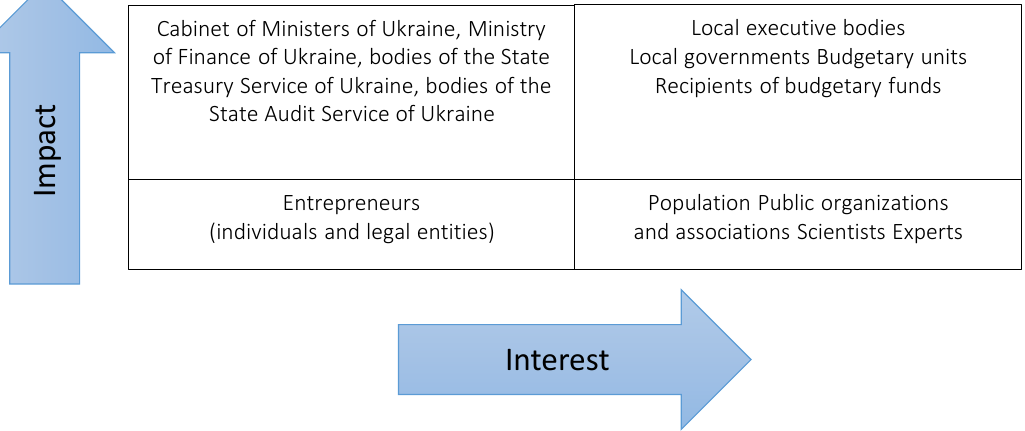
Figure 5. Stakeholders in improving the efficiency and effectiveness of the use of budget funds